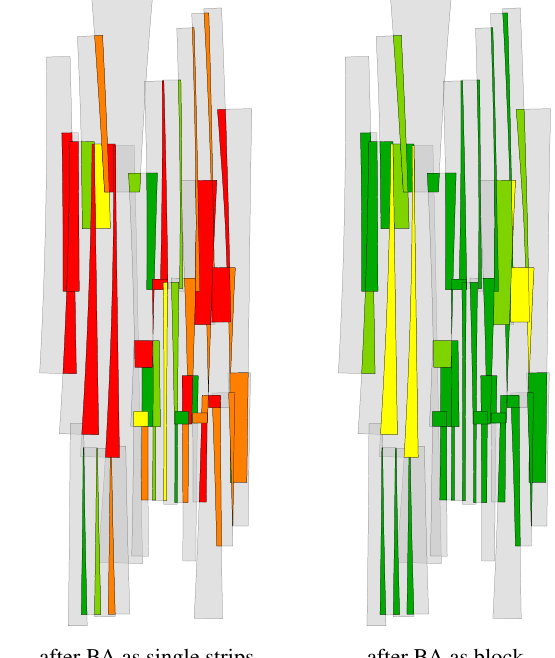
after BA as single strips after BA as block Figure 7: Mean intersection error of tie points per sub-block in